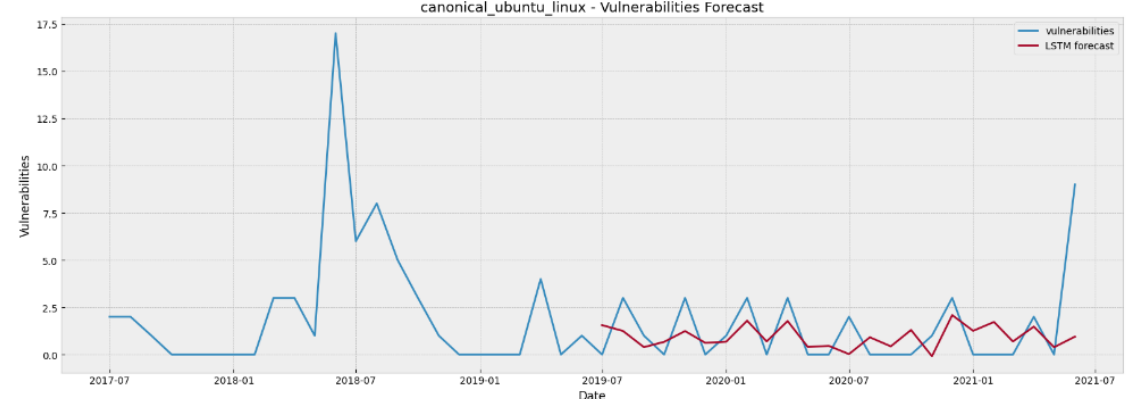
Figure 7. Ubuntu Linux vulnerability forecasting for 24 steps ahead using LSTM.